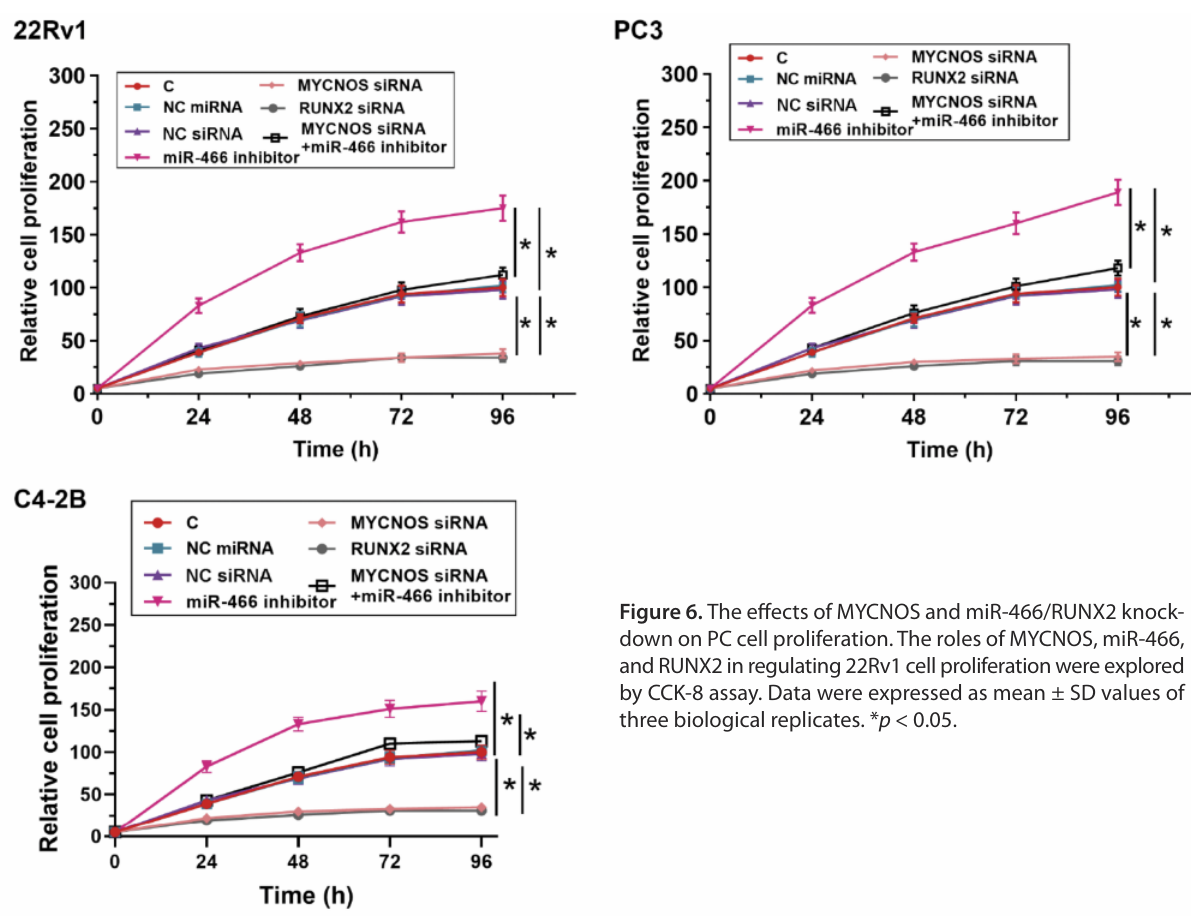
Figure 6. The e ff ects of MYCNOS and miR-466/RUNX2 knock- down on PC cell proliferation. The roles of MYCNOS, miR-466, and RUNX2 in regulating 22Rv1 cell proliferation were explored by CCK-8 assay. Data were expressed as mean ± SD values of three biological replicates. * p <